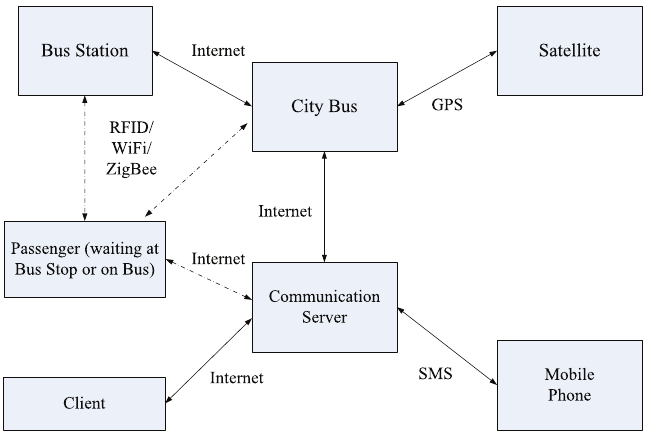
Figure 2. Architecture of the bus information system: the dashed lines represent the communication links related to passengers; the solid lines indicate the communication links between the vehicle and the